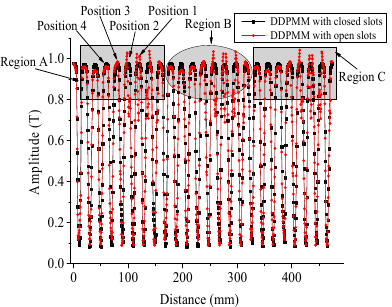
Figure 4. Air-gap flux density waveforms of the DDPMM with open and closed slots.